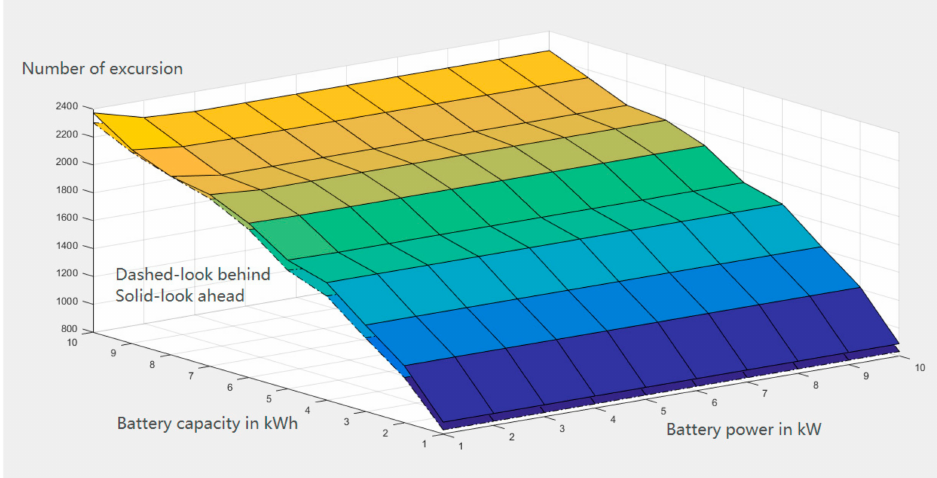
Figure 11. 3D plot of number of excursions against battery power and capacity.